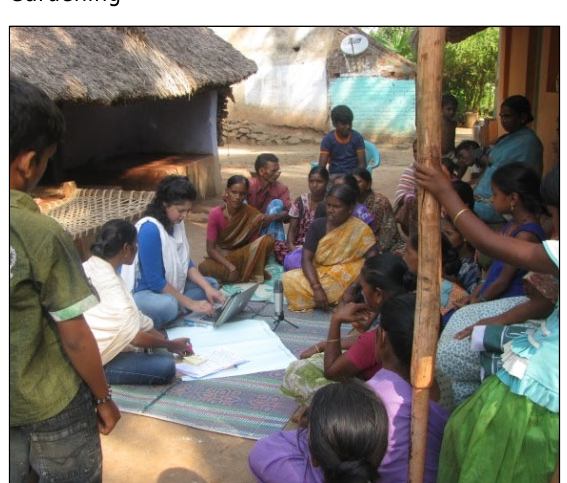
Figure 2. Participatory Rural Appraisal (PRA) to